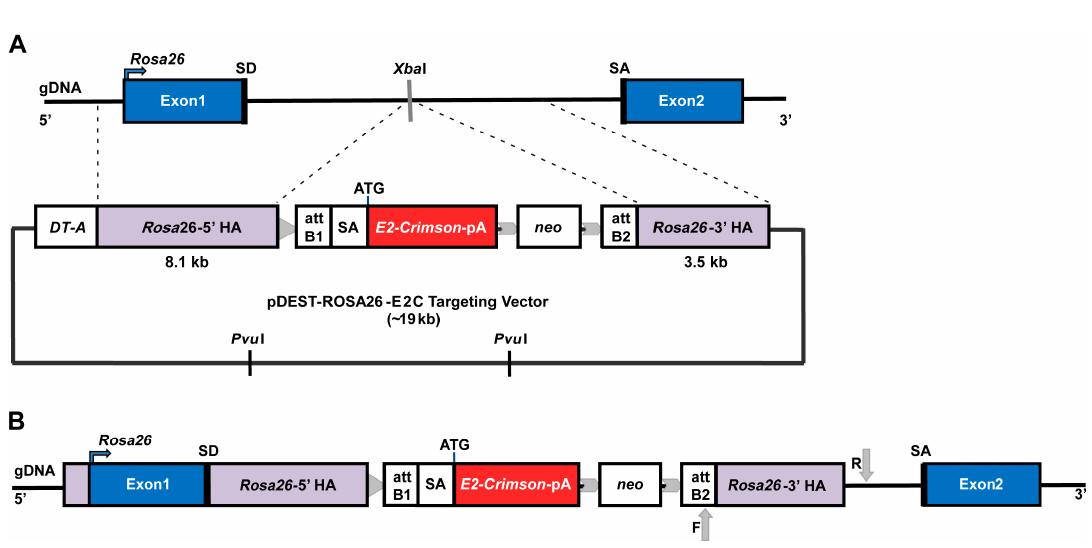
Figure 1. Schematic illustration of the Rosa26 knock-in strategy. ( A ) E14-Bra-GFP mESC Rosa26 chromosome structure and pDest-ROSA26-E2C targeting vector. The vector contains two homology arms (HAs) that flank the E2-Crimson cassette, which has a polyadenylation (pA) signal, and a downstream positive drug selection marker neo (neomycin resistance). The insertion site in between the HAs is identified by the Xba I restriction enzyme site in the Rosa26 locus. A lethal negative selection marker DT-A is placed in the 5 ′ upstream region adjacent to the targeting arm. The Pvu I restriction enzyme sites are located in the vector backbone. When linearised for gene targeting, most of the vector backbone is removed following Pvu I restriction digestion; ( B ) E14-Bra-GFP mESC Rosa26 locus with correctly targeted insertion of linearised pDest-ROSA26-E2C targeting vector. In the correct recombinants, E2C cDNA is introduced into the Rosa26 locus and is expressed under the control of the Rosa26 promoter. A loxP site (indicated with a grey triangle) is located next to the 5 ′ HA. Flippase recombinase target (FRT) sites (indicated with grey arrow heads) flanking the neo cassette are designed for optional removal of the neo cassette. Grey arrows show the forward and reverse primer-binding sites for the PCR screen of correct homologous 3 ′ -HA recombination.